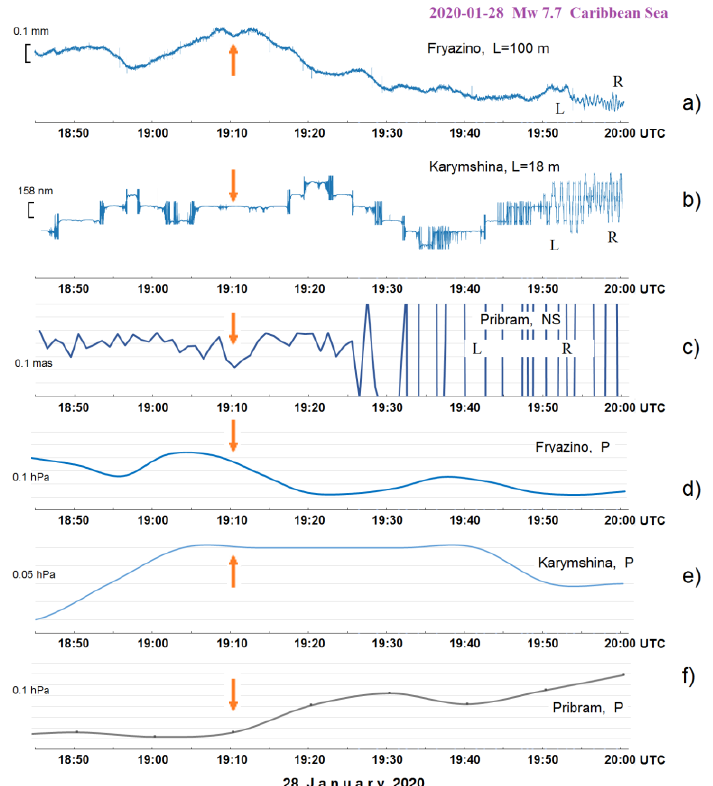
Fig. 5. Synchronous records of pre-seismic and co-seismic earth strain, tilt and atmospheric pressure variations at observation points “Fryazino” FRZ (a, d), “Karymshina” KRM (b, e) and “Pribram” PRB (c, f) in the period of Mw 7.7 earthquake in Caribbean Sea on 28 January 2020.